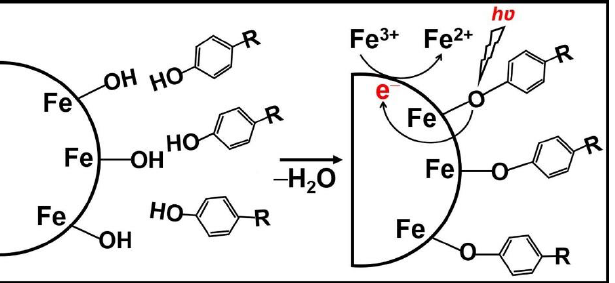
Figure 3. Schematic illustration of the ligand-to-metal charge transfer mechanism by chlorinated phenolic compounds in the Fe 3 O 4 NPs system [43] . Copyright, 2020 Elsevier Inc.